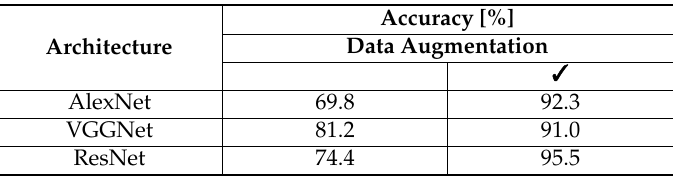
Table 3. Result of deep classification. AlexNet; Visual Geometry Group Network ( VGGNet ); Deep residual network ( ResNet ). Table 2. Result of conventional classification. Speeded-up robust features (SURF); histogram of oriented gradient (HOG); co-occurrence HOG (CoHOG); extended CoHOG (ECoHOG); local binary pattern (LBP); red, green, blue (RGB); hue, saturation, value (HSV); gray level co-occurrence matrix (GLCM); GIST. L*a*b*